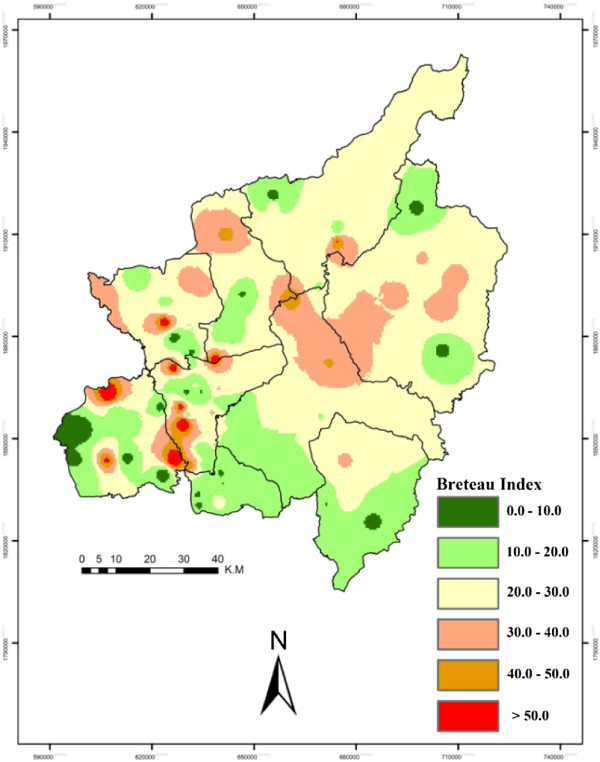
Province level Breteau index (B.I.). This map is a visual presentation of B.I., i.e. the number of positive containers per 100 houses inspected, using interpolation techniques on the basis of sampled villages. The legend colors show the levels of B.I. from low (green) to high (red). As per the National Institute of Health (NIH) Thailand, a B.I. of less than 5% is considered to be low risk and greater than 50% is considered to be higher risk.